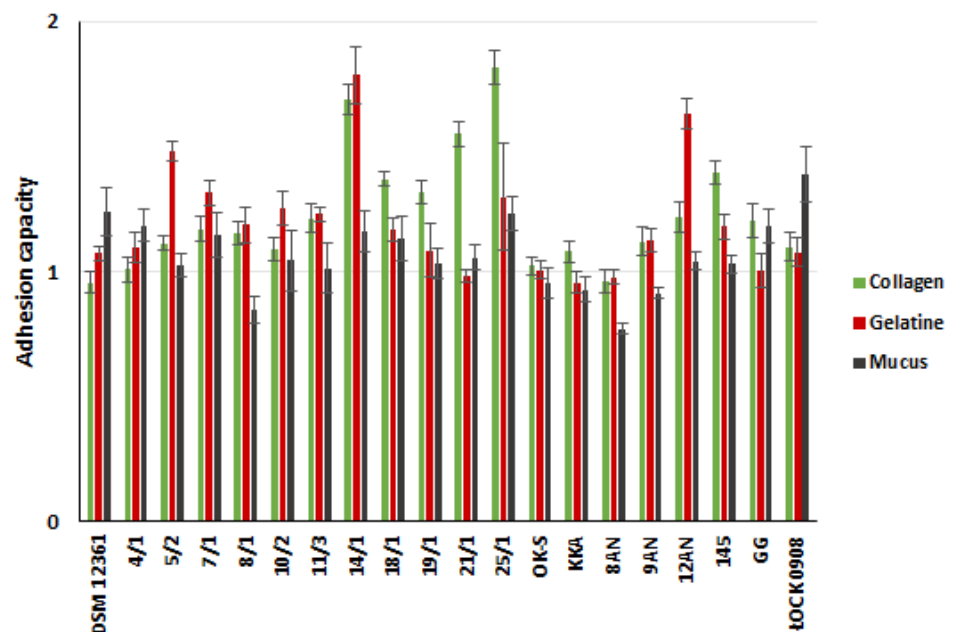
Figure 2. The capacity of lactic acid bacteria (LAB) to adhere to biotic surfaces. Adhesion capacity: A ≤ 1 no adhesion; 2 ≥ A > 1 weak adhesion; 3 ≥ A > 2 medium adhesion; A > 3 strong adhesions. Each data point represents the means from four individual wells. Results are presented as mean ± standard deviation (S.D.).